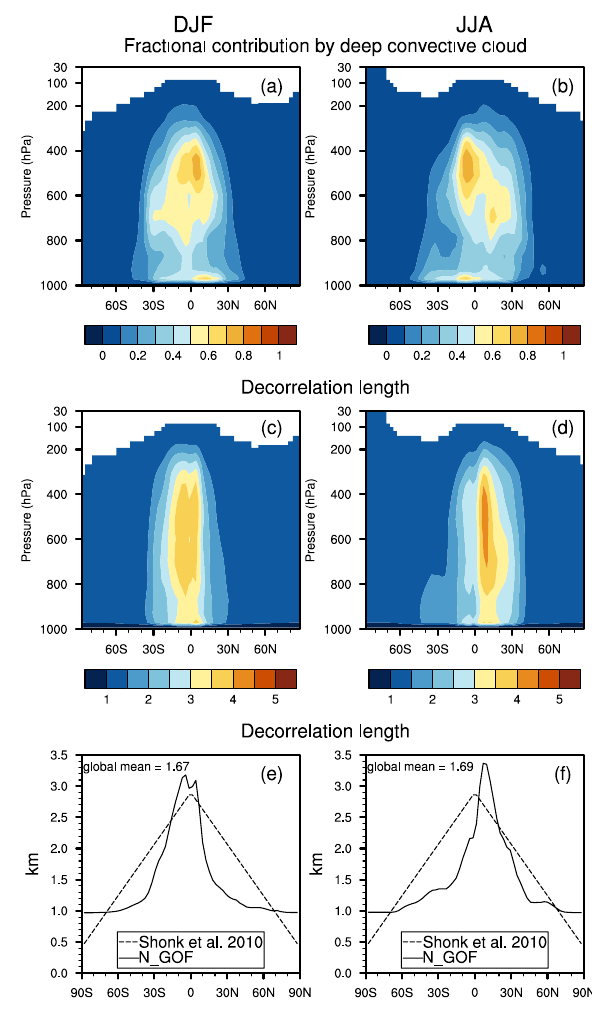
Fig. 7. Zonal annual mean (a, b) fractional contribution by deep convective cloud fraction ( f con /f tot ) and (c, d) L cf calculated using Eq. (8) from the N_GOF run, as well as (e, f) the vertically averaged L cf for N_GOF (solid lines) and that used by Shonk et al. (2010) (dashed lines), for DJF (left) and JJA